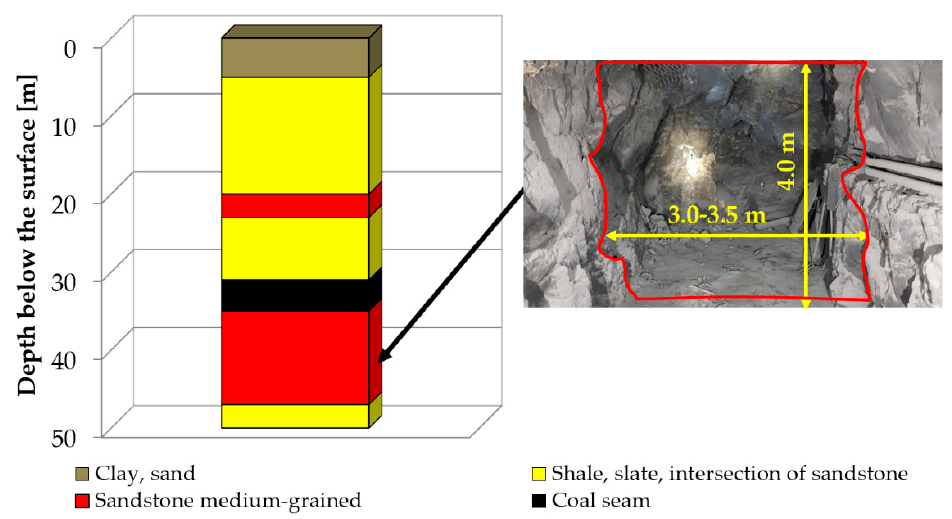
Figure 1. Stratigraphic profile of the GIG Experimental Mine ‘Barbara’.